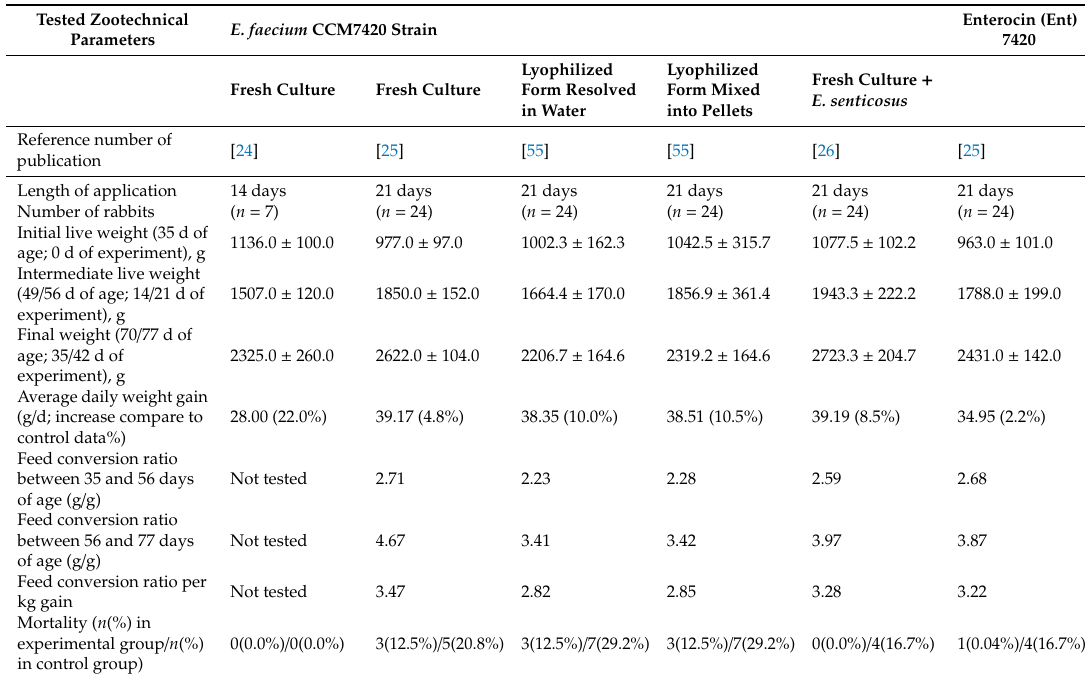
Table 1. The e ff ect of Enterococcus faecium CCM7420 and its enterocin Ent7420 on the growth performance of